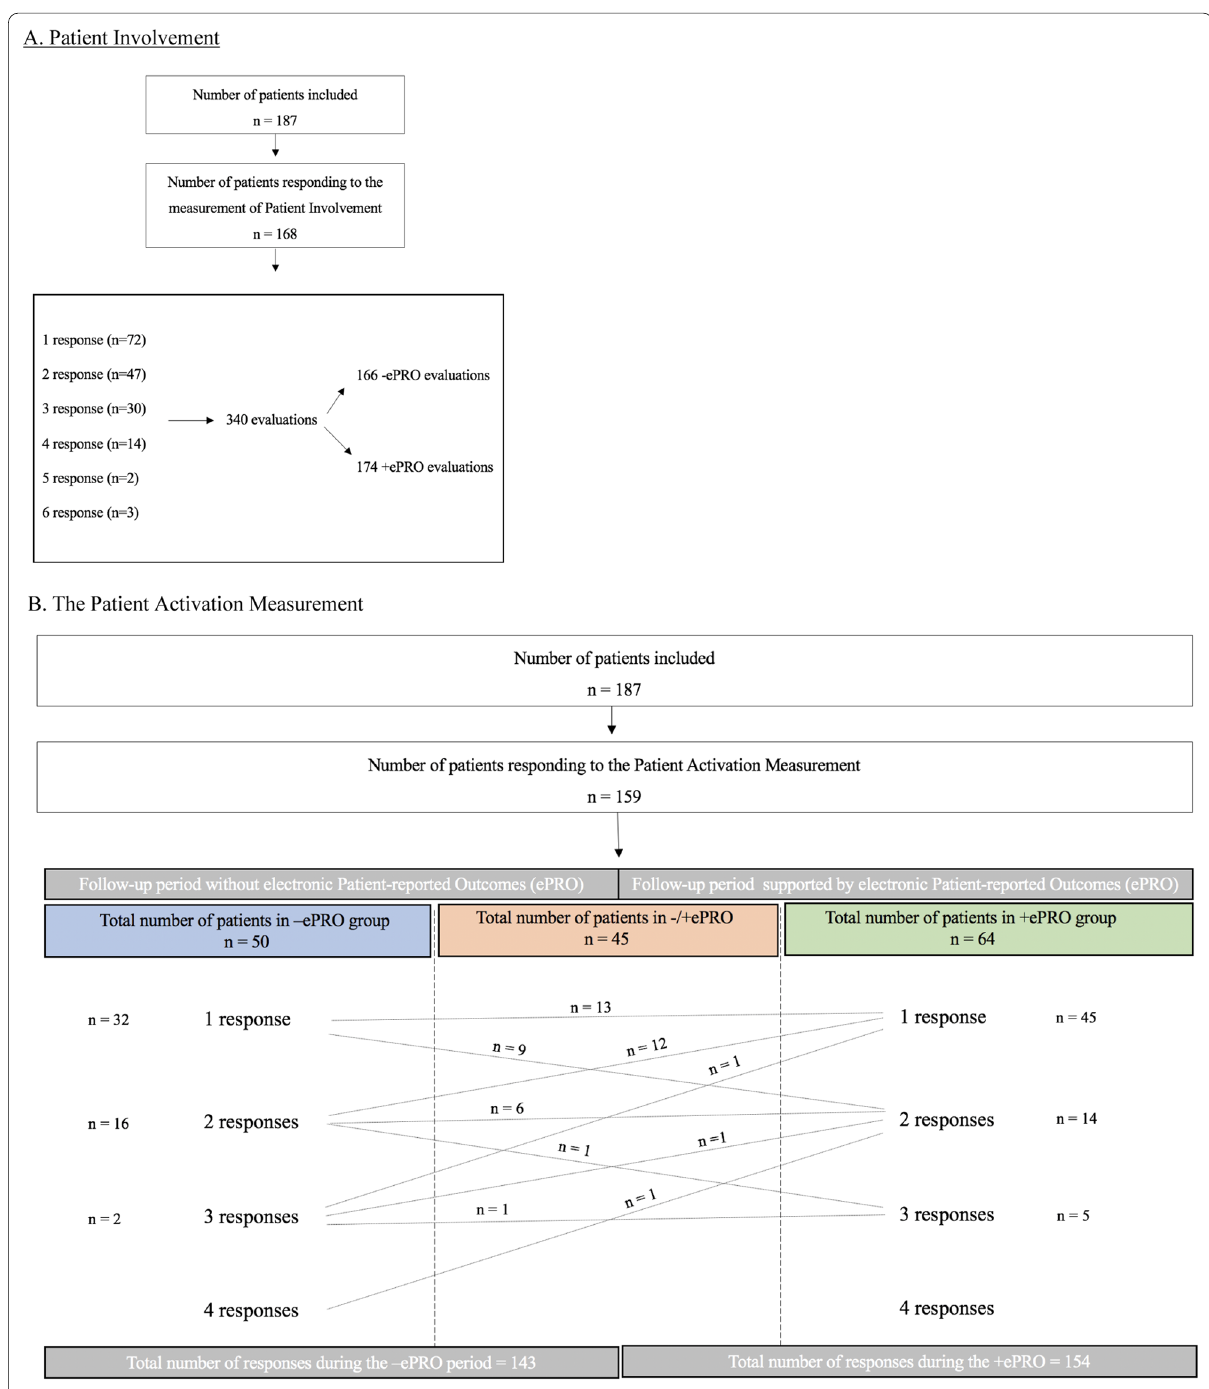
Fig. 3 Demonstrates the number of patients included into the study (n measurements of patient involvement ( a ) (n responses for each patient in the different follow-up periods. The routine follow-up without electronic Patient-reported Outcomes (ePRO) is referred to as ePRO, whereas the follow-up period supported by electronic Patient-reported Outcomes (ePRO) are referred to as − demonstrate the number of responses each patient had in the